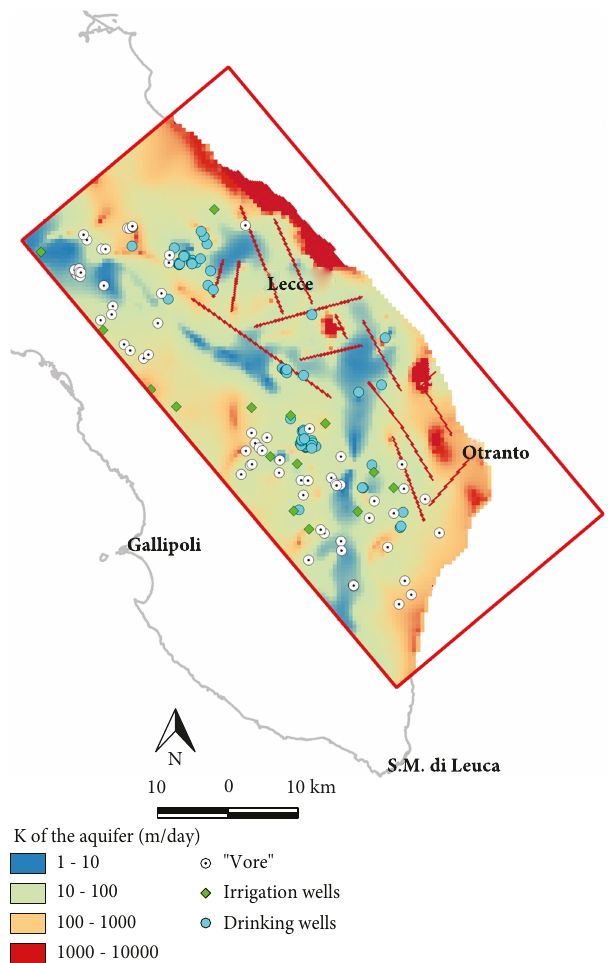
Figure 5: Location of irrigation and drinking pumping wells and “ vore. ” The color map refers to the horizontal hydraulic conductivity distribution used for the deep aquifer in the modelling